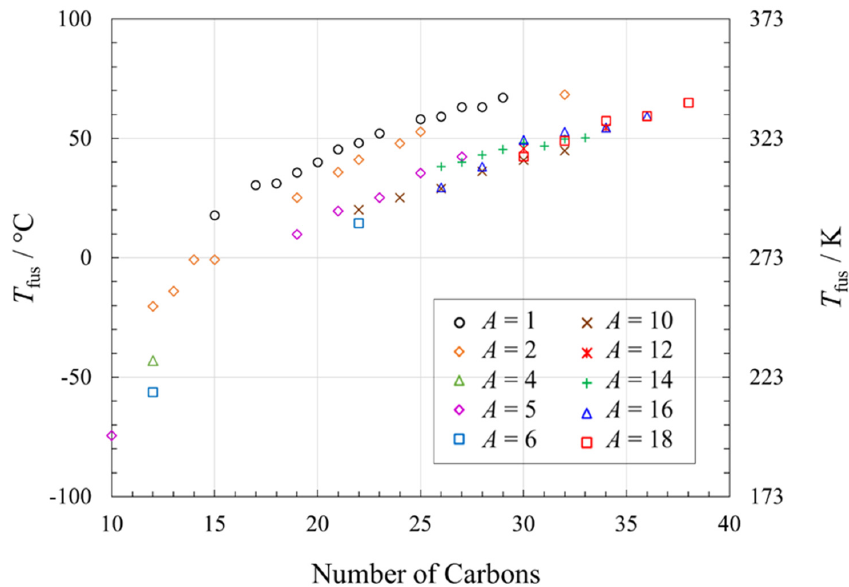
Figure 3. Melting points of esters of general formula CH 3 (CH 2 ) m − 1 -O-C(O)-(CH 2 ) n - m − 2 CH 3 where A is the length of the alkyl chain ( A = m ), as a function of the total number of carbons. See Supplementary Information for data and data sources.